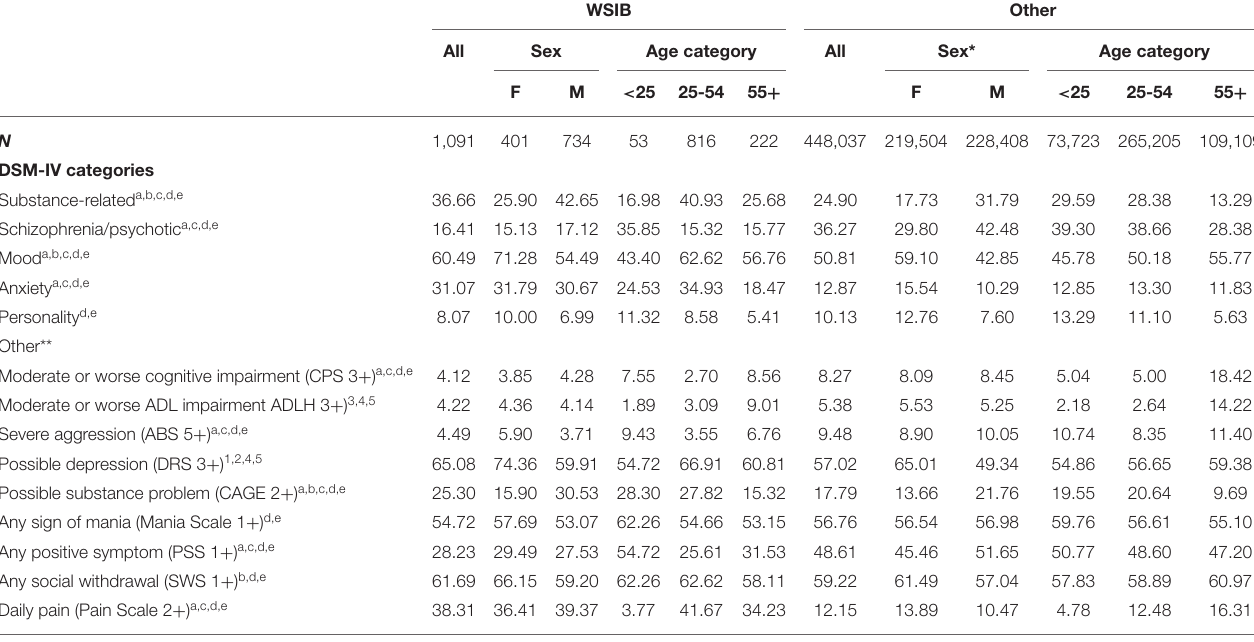
TABLE 3 | Univariate distribution (%) for clinical characteristics overall, and by WSIB status, sex, and age. WSIB Other All Sex Age category All Sex* Age category F M < 25 25-54 55 + F M <